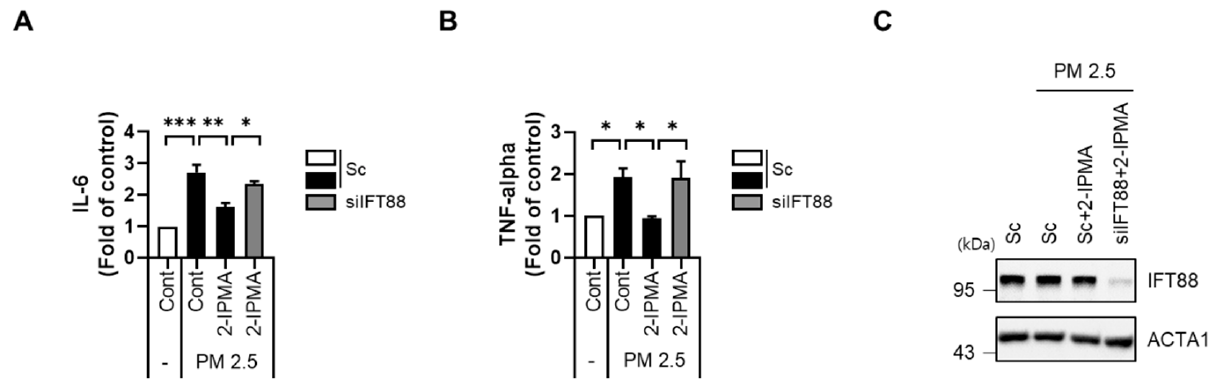
Figure 5. 2-IPMA inhibits pro-inflammation cytokine production of IL-6 and TNF- α induced by PM2.5 in RPE cells. RPE cells transfected with either scrambled siRNA (Sc) or siRNA against IFT88 (si IFT88 ) were further exposed to PM2.5 (50 μ g/mL) with 2-IPMA (100 μ M) for 24 h. Then the expression levels of IL-6 ( A ) and TNF- α ( B ) in the culture condition were measured using an ELISA assay. The reduced expression of IFT88 was measured by Western blotting ( C ). ( n = 3, * p < 0.05, ** p < 0.01, and *** p < 0.001)